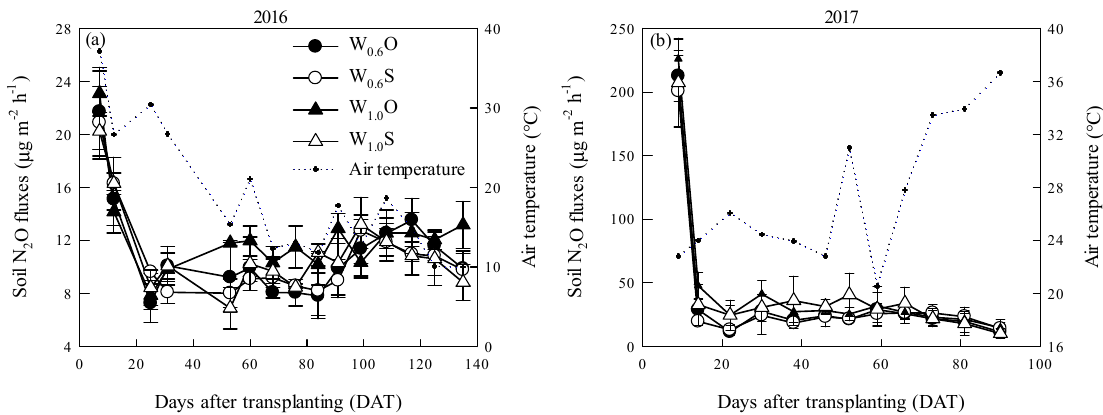
Figure 1. Variations of soil N 2 O fluxes among treatments and air temperature in the greenhouse for the tomato-growing seasons of 2016 ( a ) and 2017 ( b ). Error bars represent standard error ( n = 3). W 0.6 O is 60% of the full irrigation with aeration; W 0.6 S is 60% of the full irrigation with control; W 1.0 O is 100% of the full irrigation with aeration; W 1.0 S is 100% of the full irrigation with control. Average soil N 2 O flux of the whole growth period of 2016 under W 0.6 O, W 0.6 S, W 1.0 O, and W 1.0 S treatment was 10.81, 10.60, 11.97, and 10.85 μ g ∙ m − 2 ∙ h − 1 , respectively. The highest mean value of soil N 2 O fluxes in 2017 occurred under W 1.0 O (44.75 μ g ∙ m − 2 ∙ h − 1 ), which was 1.19-, 1.23-, and 1.04-fold greater than under W 0.6 O, W 0.6 S, and W 1.0 S, respectively.